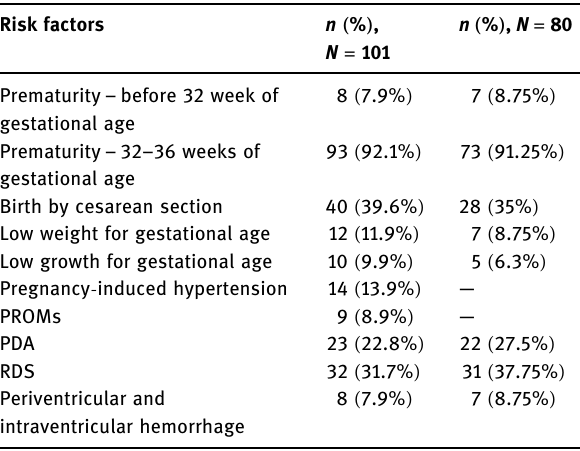
Table 1: Risk factors for neonatal sepsis Risk factors